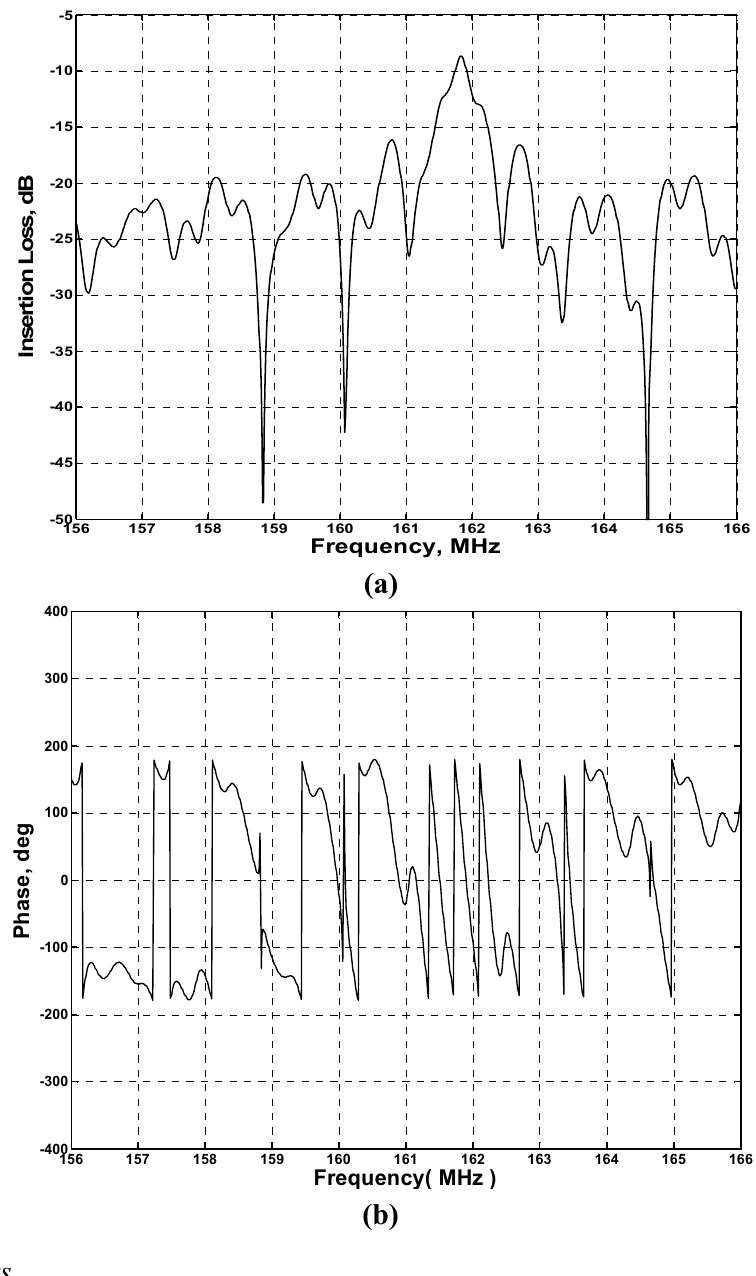
Figure 5. The measured amplitude (a) and phase (b) response of the fabricated SAW